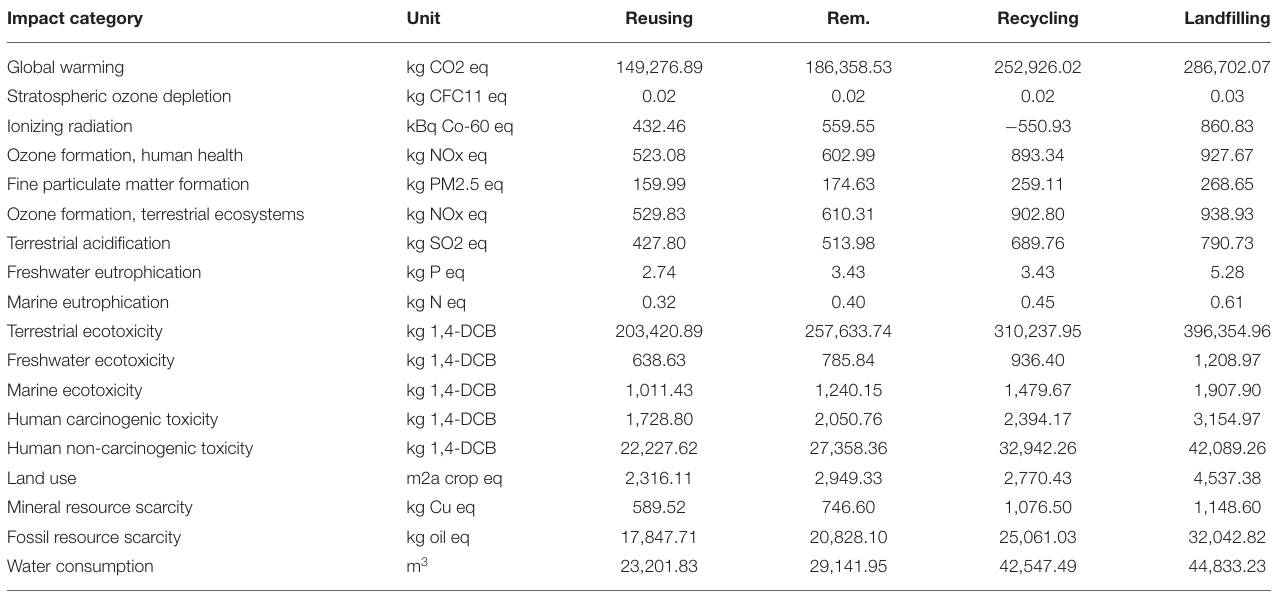
TABLE 2 | Impact of reverse logistics practices on the